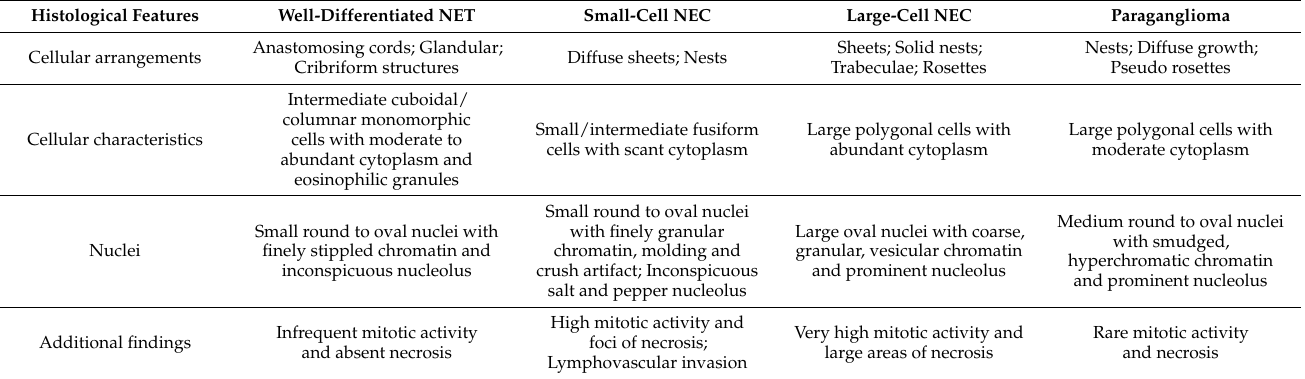
Table 5. Histological characteristics of urinary bladder NENs